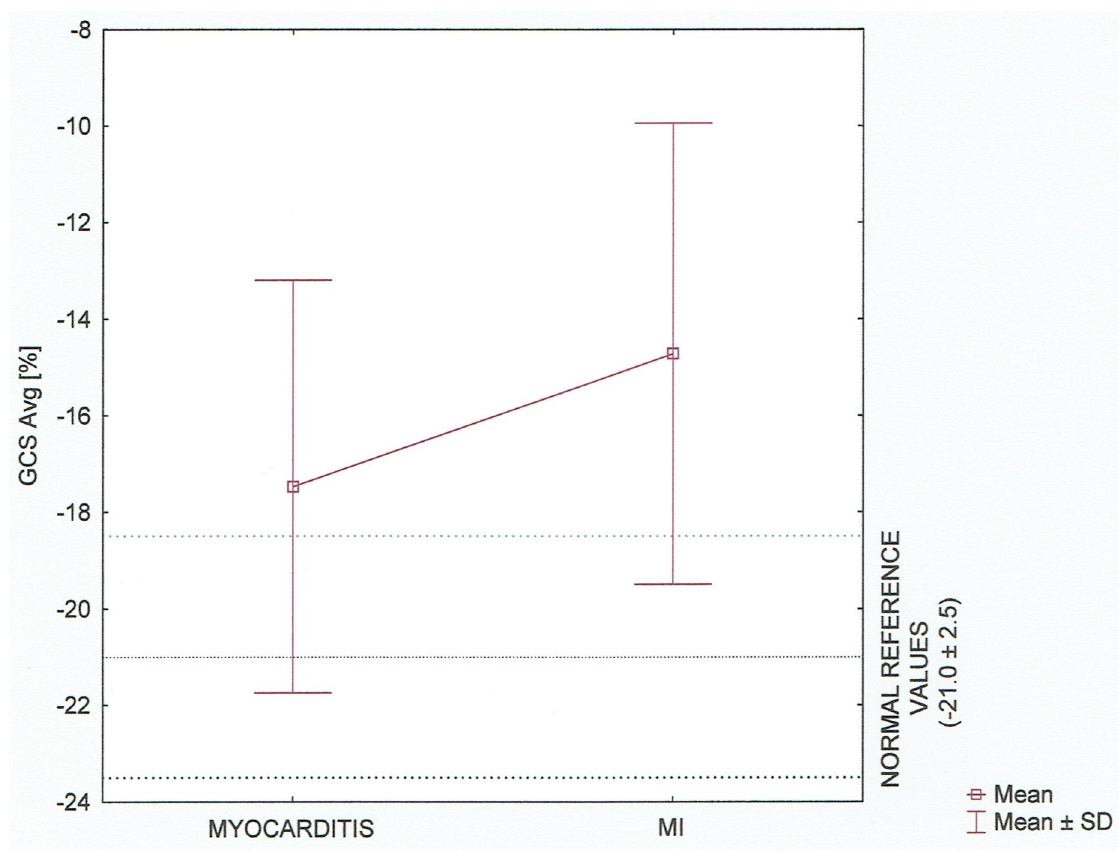
Fig 5. Global circumferential strain (average) [%] concerning normal reference values. Tukey boxplot (mean ± SD).